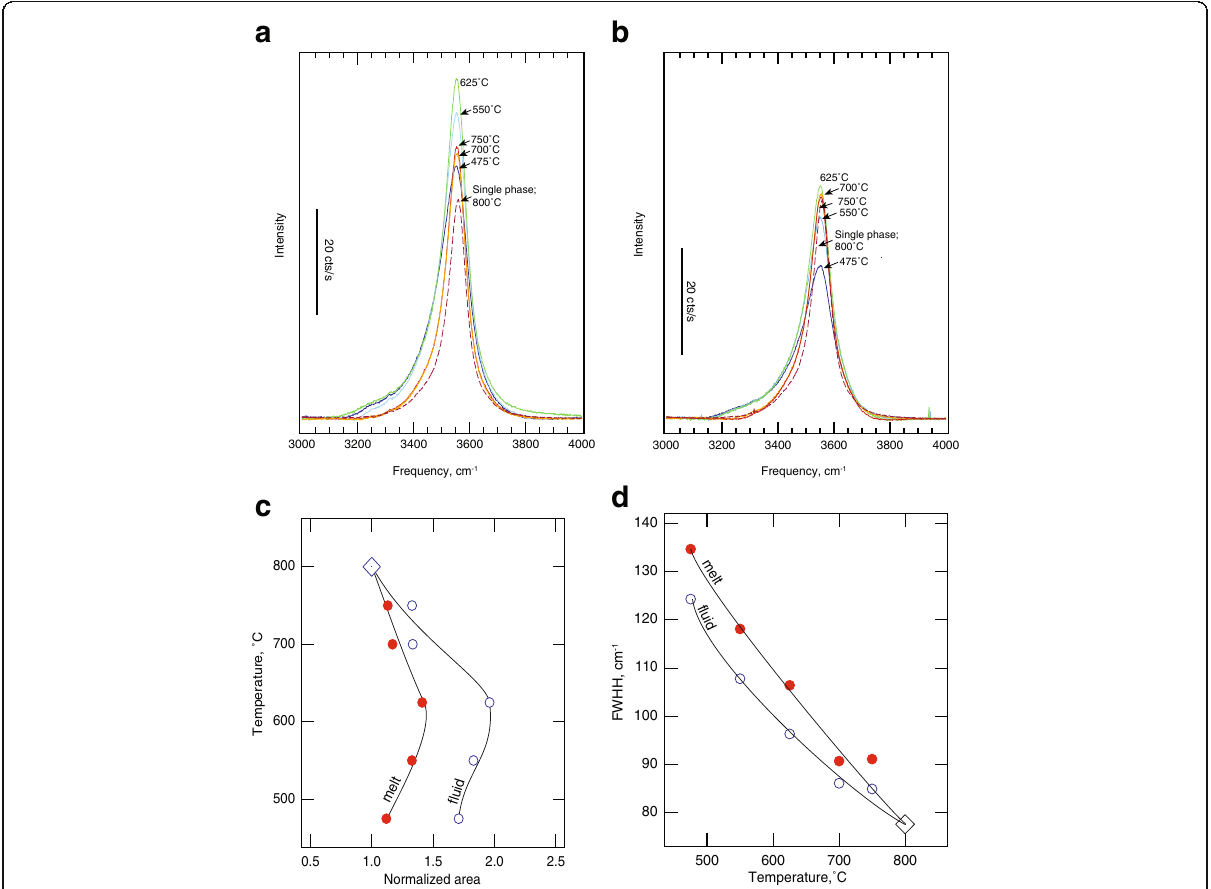
Fig. 5 Raman spectra of coexisting fluid and melt in the high-frequency region of fundamental O – H vibrations. a Spectra of fluid at temperatures indicated (corresponding pressures can be found in Table 1). b Spectra of coexisting melt (corresponding pressures can be found in Table 1). The spectra are normalized to the same acquisition time with identical focal plane and with otherwise identical instrumental parameters. c Normalized areas of coexisting melt and fluid as indicated. d Full width at half height, FWHH, from the spectra in Figs. A and